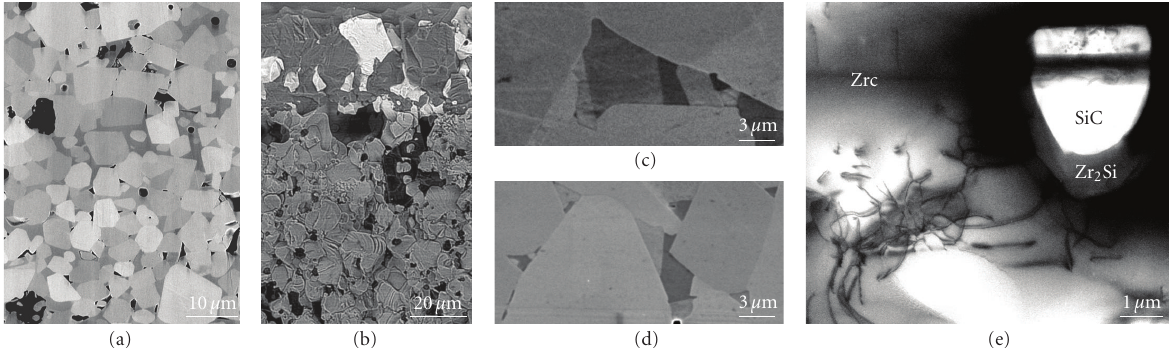
Figure 3: (a) SEM micrographs of the polished surface of ZC20; the bright phase is ZrC, the grey phase is MoSi 2 , the dark irregular particles are SiC, whilst the little rounded dark ones are residual porosity. (b) BSE-SEM image of the fracture surface showing a 15 μ m-thick SiC layer on the edge of ZC20. (c) Zr-Si phases at the interface ZrC-MoSi 2 . Darker regions correspond to Si-richer Zr x Si y phases. (d) Wetted grain boundaries and Zr-Si phases with di ff erent stoichiometry indicating local crystallization from liquid phase. (e) BF-TEM image of ZC20 composite showing the formation of SiC on Zr 2 Si